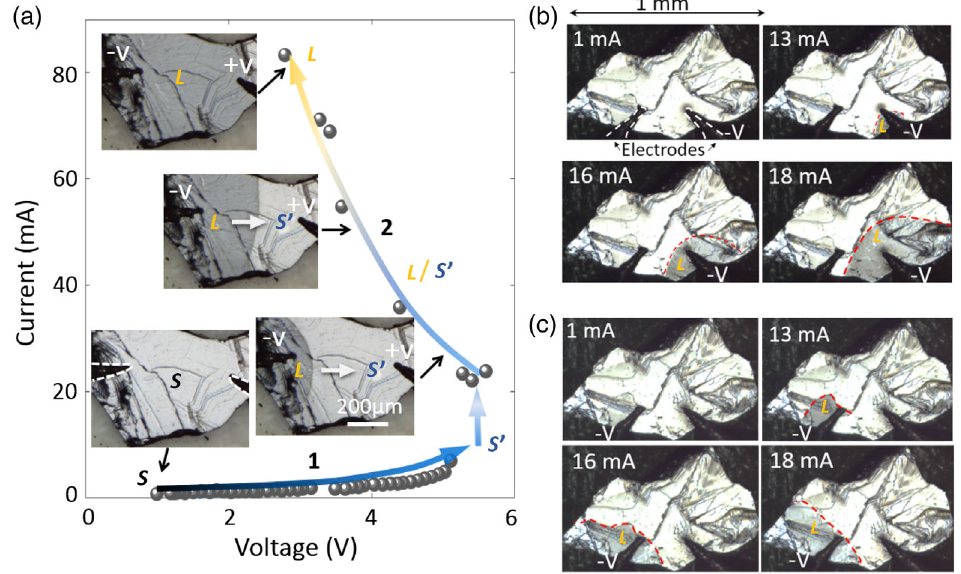
FIG. 1. dc transport characterization and optical photographs of a Ca 2 RuO 4 bulk single crystal at different stages of the IMT. (a) A dc I - V curve with optical images taken by a CCD camera in the visible range. The insets show the emergence and expansion of the L phase (dark region) at each stage of the phase transition. The white dashed line in the bottom inset outlines the silver paint electrodes on the sample surface. (b) and (c) show the switching of the L phase from the right to left electrode via reversing the polarity of the two electrodes (outlined by the white dashed